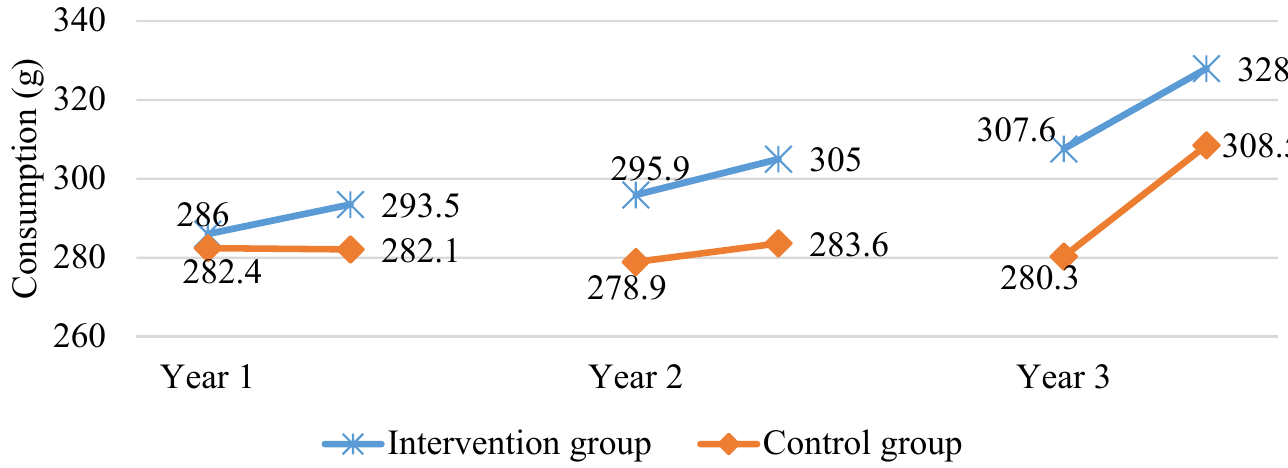
Figure 3. Total fruit and vegetable consumption (on both school and weekend days) during the three years of the study.